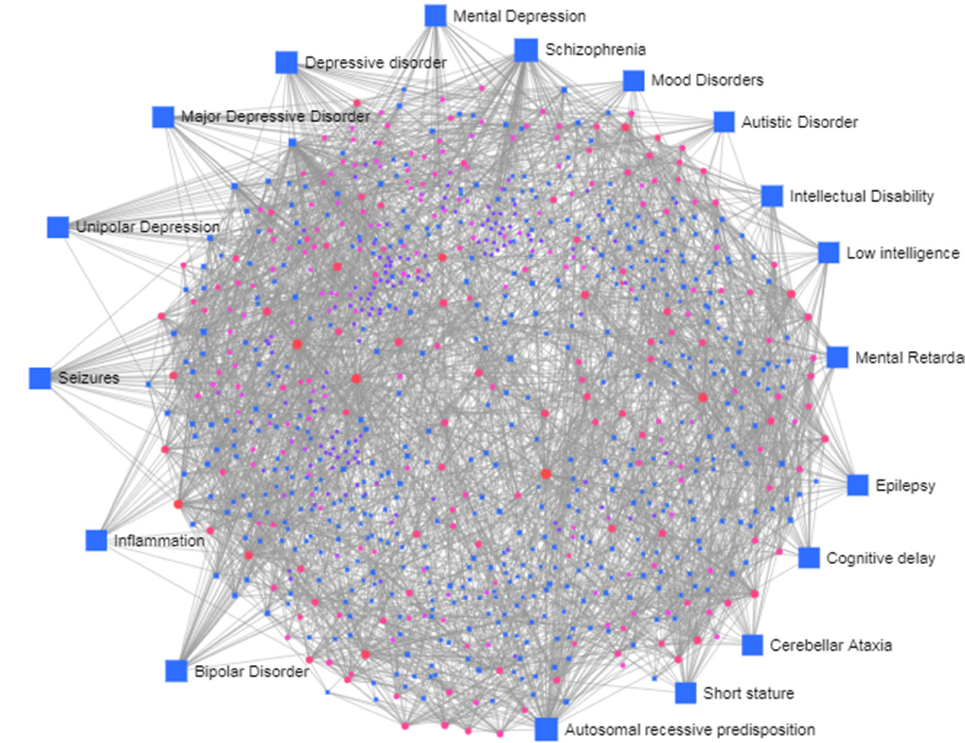
Figure 6. Network constructions of differentially expressed genes and transcription factors. Pink indicates genes and blue squares represent transcription factors. The grey lines represent interaction. The larger blue squares show important disease pathways.